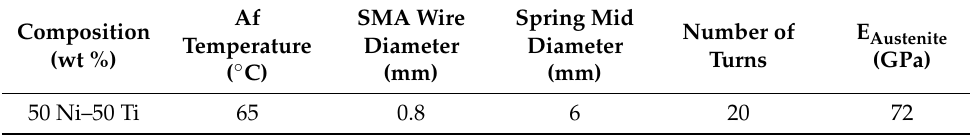
Table 1. SMA spring performance